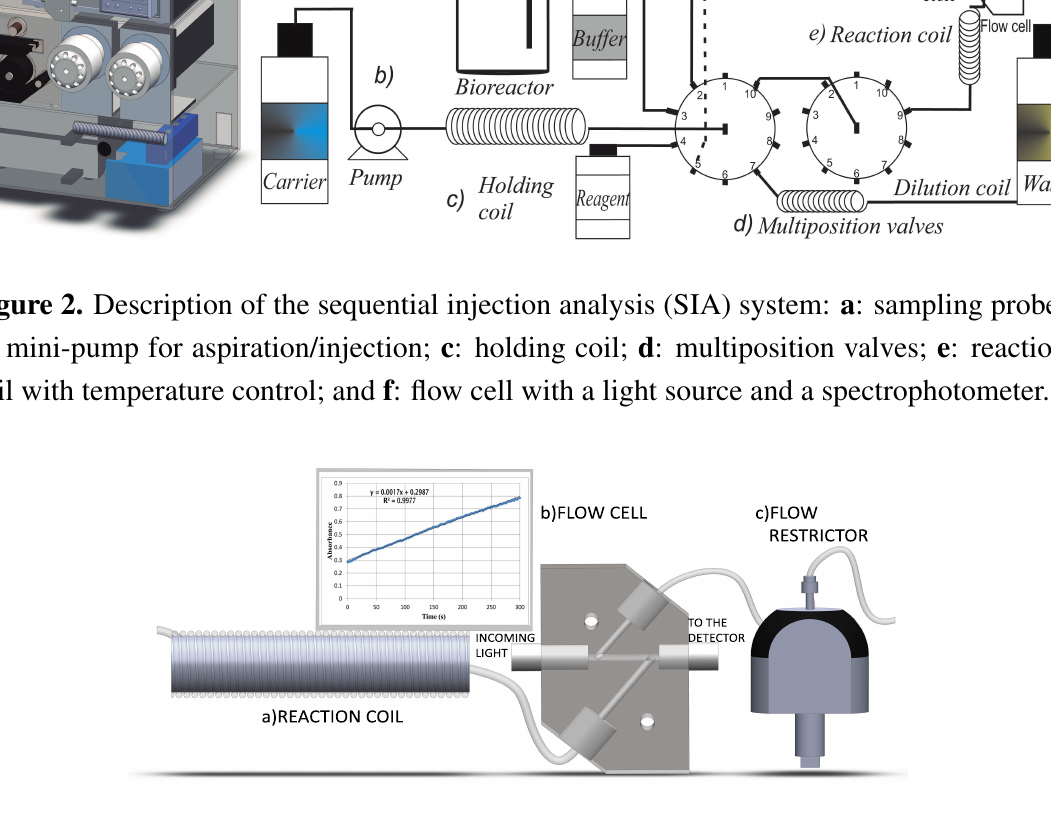
Figure 3. The components used to measure compounds in the SIA system: a : reaction coil; b : flow cell; and c : flow